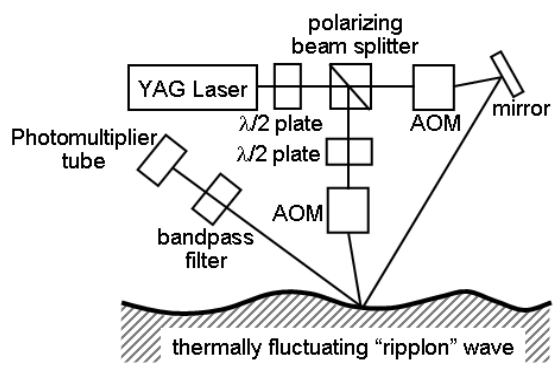
Fig. 1 Schematic setup of SW method 3)